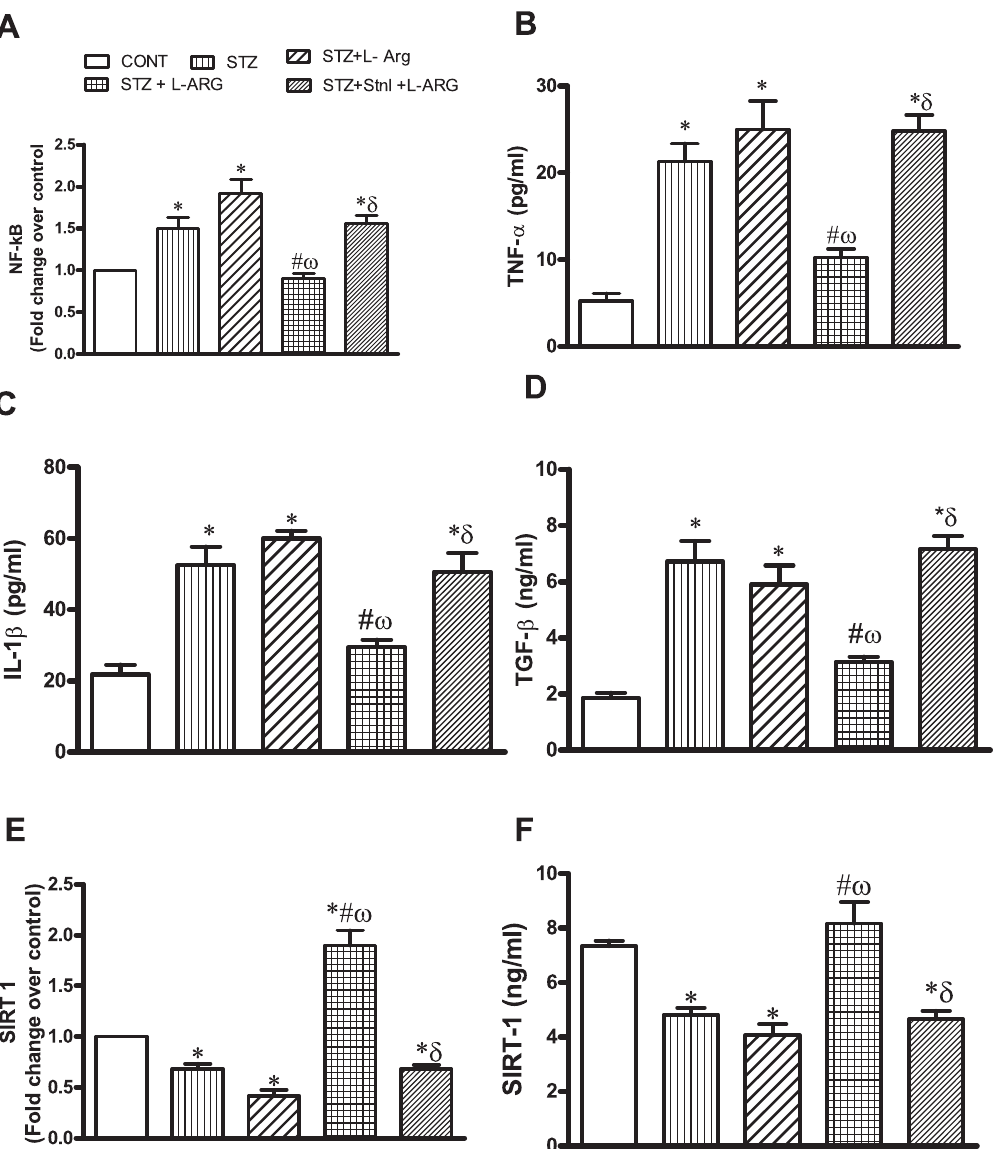
Fig. 4. Effect of STZ alone or in combination with L-ARG or L-ARG + Stnl on (A) nuclear factor kappa (NF k )-B mRNA expression, (B) tumor necrosis factor alpha (TNF- a ) protein content, (C) interleukin 1 (IL-) b protein content, (D) silent information regulator (SIRT-1) mRNA expression and (E) its protein content. Data represent the means of six experiments ¡ SEM; *, # , v and d P , 0.05 compared with CONT, STZ, STZ + Stnl and STZ + Stnl + L-ARG, respectively, using one-way ANOVA followed by Tukey’s Multiple Comparison